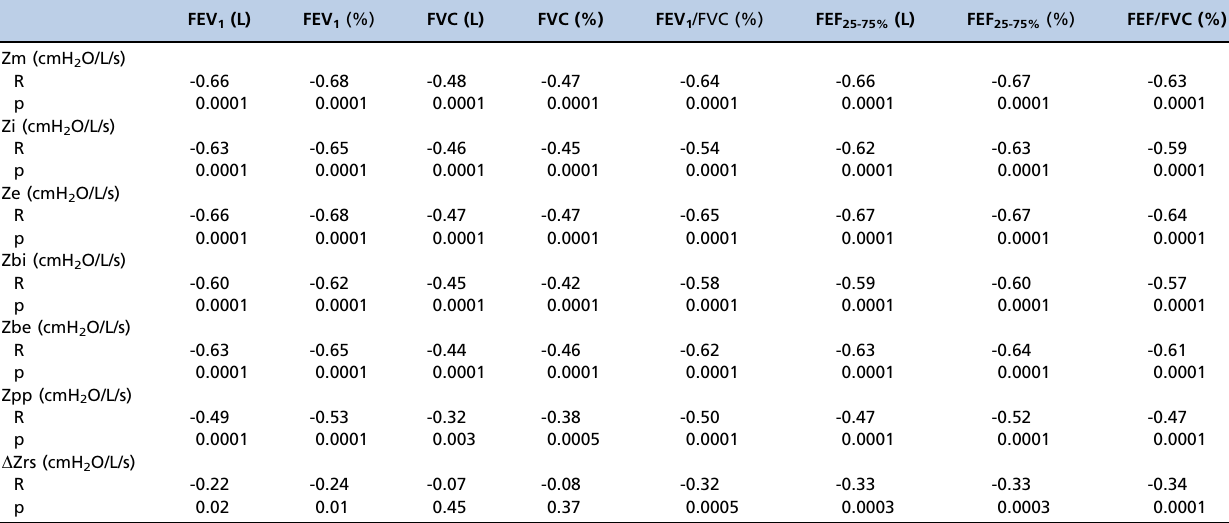
Table 2 - Correlation coefficient for and significance level of the association between respiratory impedance and pulmonary function